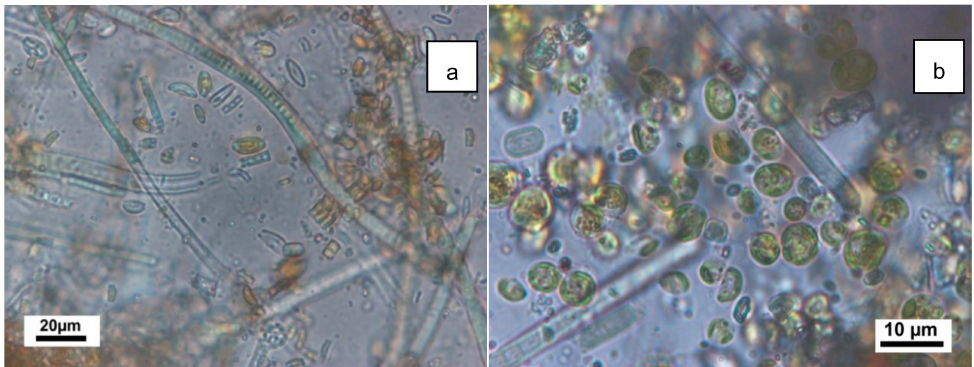
Figure 8. Photograph of samples taken using optical microscopy: ( a ) diatoms of the Cymbella , Navicula and Achnanthes genera and filaments of Phormidium sp. can be seen on the left; ( b ) on the right, there are cells of Bracteacoccus sp. and filaments of Phormidium